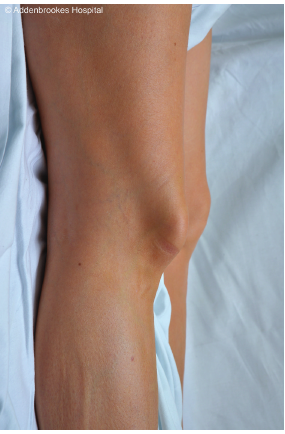
Figure 2: Lateral view of the patients’ knee highlighting tenting of the soft tissues over the patella.